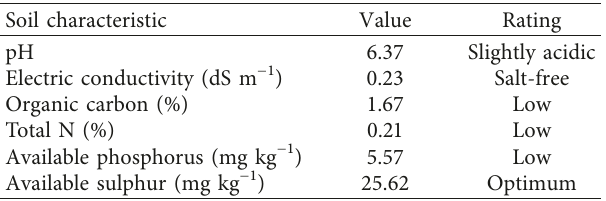
Table 2: Chemical characteristics of the experimental soil